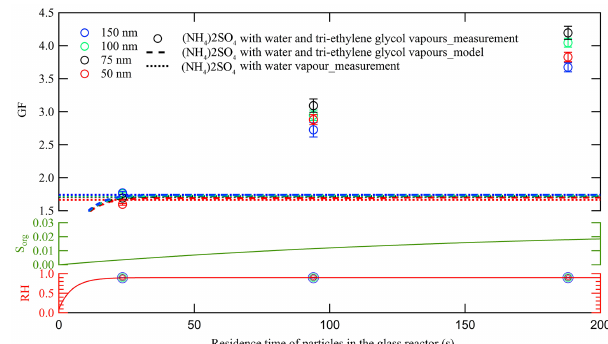
Figure 5. Measured (circle) and simulated GF (dash line) with res- idence time for (NH 4 ) 2 SO 4 particles exposed to water and TEG vapours. The simulated RH and S org profiles, which following the same exponential function as the experiment with PG vapour, are presented as solid red and green lines,